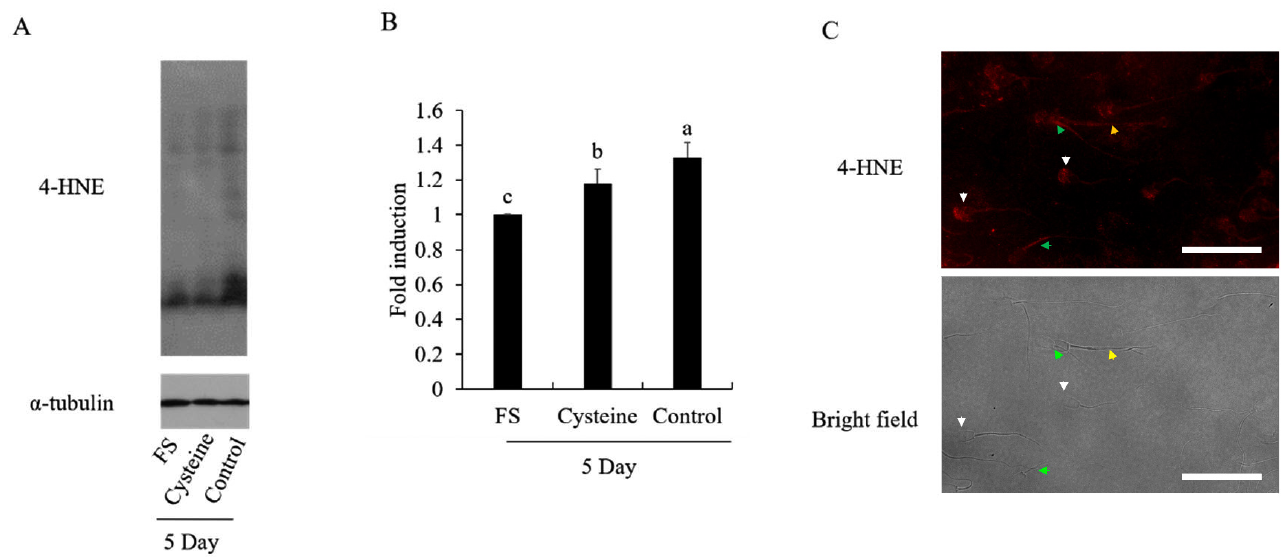
Figure 3. (A-B) Western blotting analysis of the effect of cysteine on 4-HNE modifications in boar sperm after 5-days’ preservation. Western blot - ting image is showing the expression of 4-HNE modifications in boar sperm (A). (B) Quantitative expression of the 4-HNE over α-tubulin generated from western blotting (A). Immunofluorescent localization of 4-HNE in boar sperm (C). Data are the mean±standard deviation (SD). 4-HNE, 4-hy - droxyIlonenal. a-c Columns with different lowercase letters differ significantly (p<0.05). Bars = 30